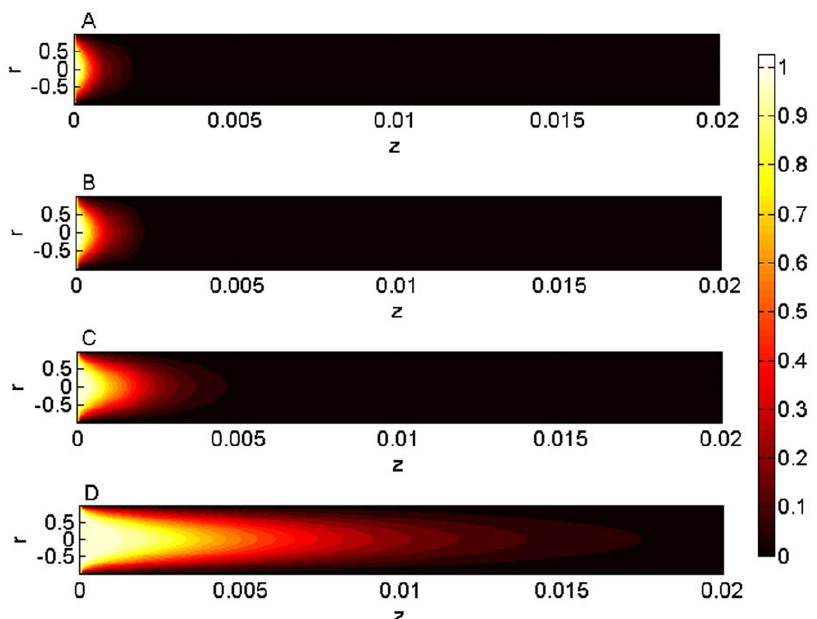
Figure 5. The temperature profiles of the nanofluid corresponding to different nanoparticle volume fractions. ( A )–( D ) Comparison of the axial temperature profiles for w ~ 0, 1%, 3% and 5% with a fixed pressure gradient equal to 2 | 10 6 Pa/m and dimensionless slip length L 0 = a ~ 0 : 01 , showing the effect of nanoparticle volume fraction on the temperature distribution. s